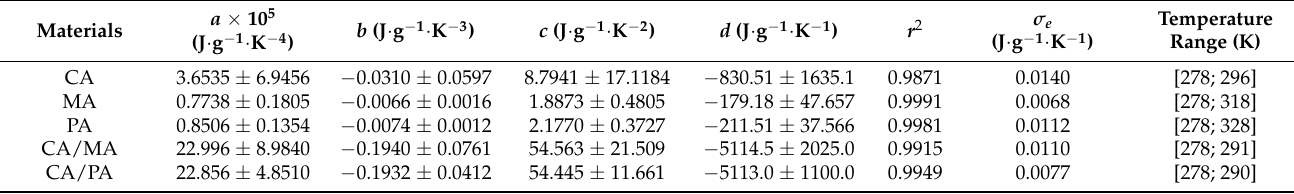
Table 7. Specific heat of the solid phase—Estimated values of the coefficients a , b , and c in the equation C P , S ( T ) = aT 3 + bT 2 + cT + d ( r 2 = coefficient of determination; σ e = standard deviation of the error) at pressure p = 0.1 MPa *. a × 10 Materials